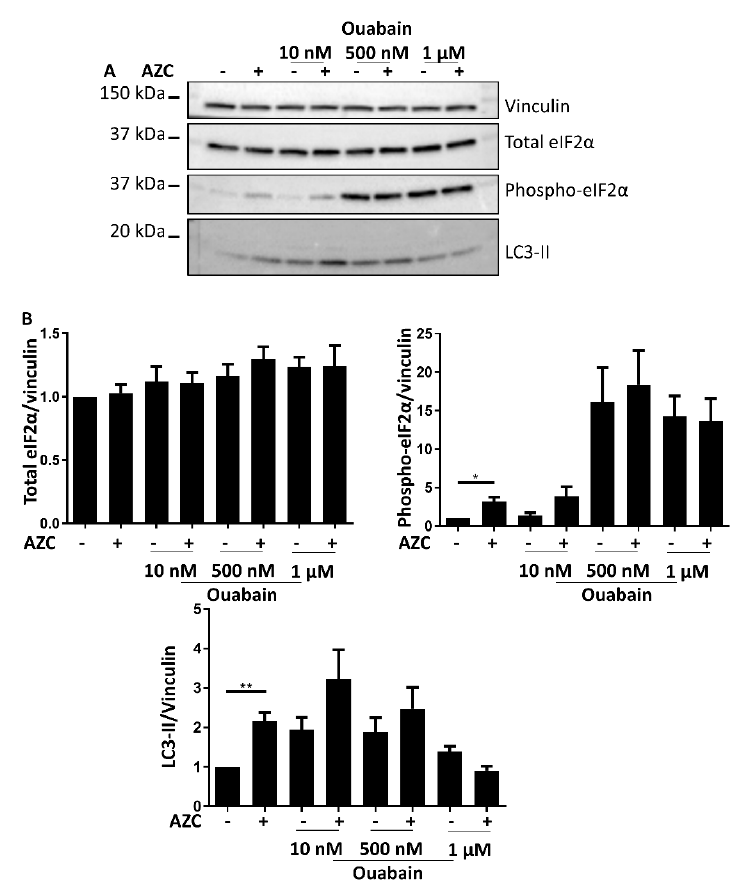
Figure 7. Ouabain affects ER stress, apoptosis and autophagy markers differently than BAPTA-AM. Cells were treated for 6 h with 5 mM AZC in absence or presence of 10 nM, 500 nM, or 1 µ M of the Na + /K + ATPase inhibitor ouabain, and during the last 4 h 100 nM Baf A1 was added. ( A ) A representative blot of eight independent experiments each performed in duplicate showing levels of total eIF2 α and phospho-eIF2 α , and of LC3-II. Vinculin was used as loading control. ( B ) Quantification of protein levels in ( A ) shown as mean ± SEM relative to untreated control. * p < 0.05, ** p < 0.01.